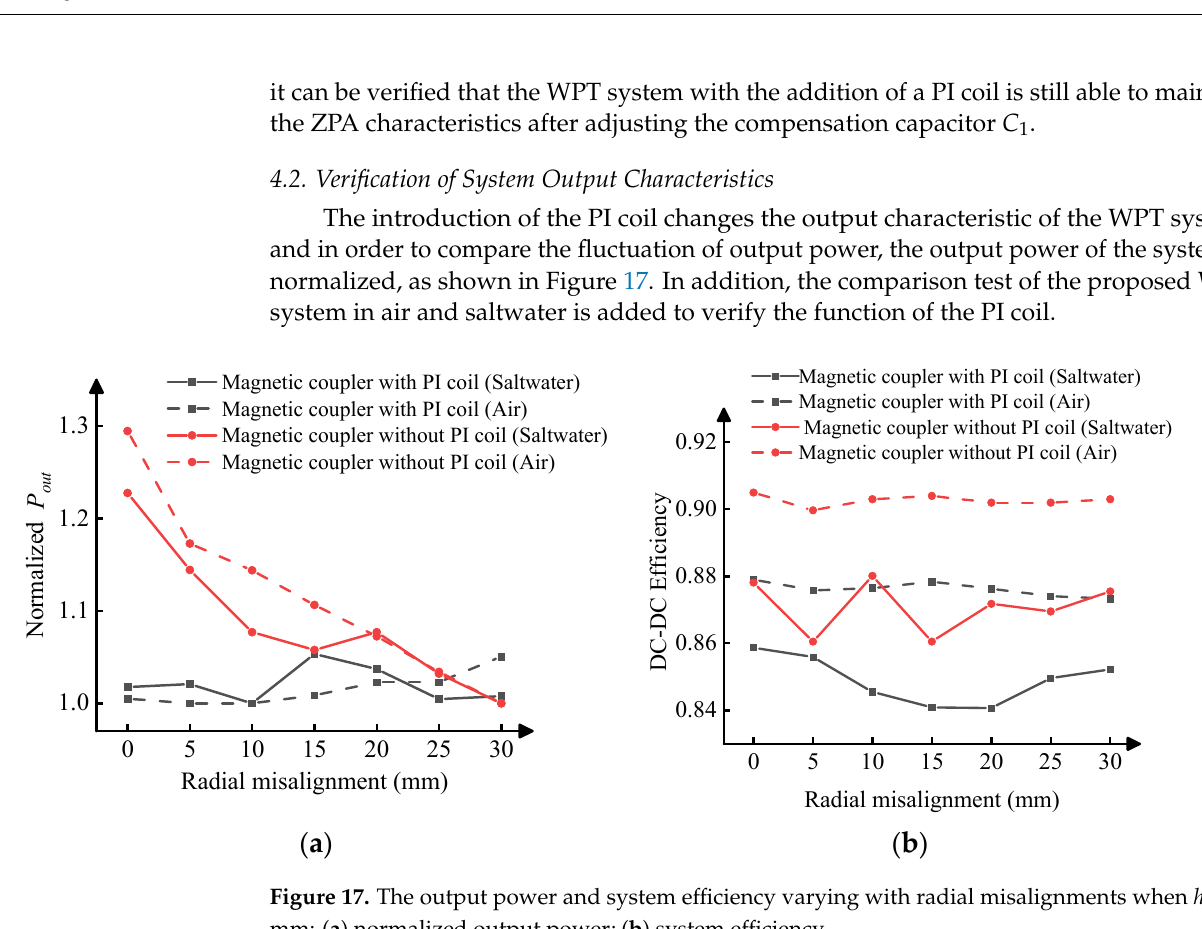
Figure 17. The stability of the output power of the system is improved significantly with